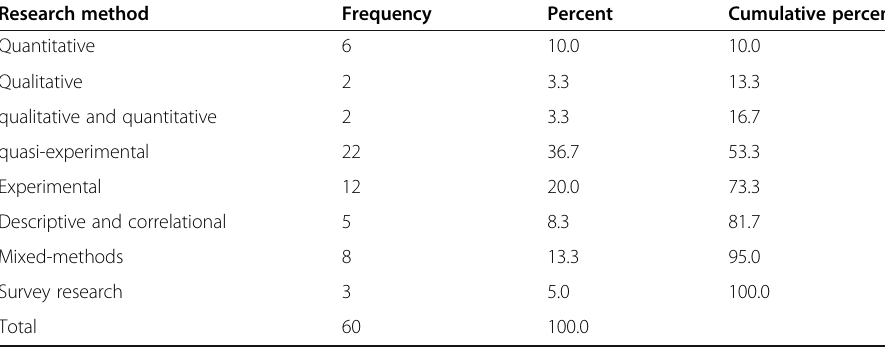
Table 2 Frequency distribution of researches by research method Research method Frequency Quantitative